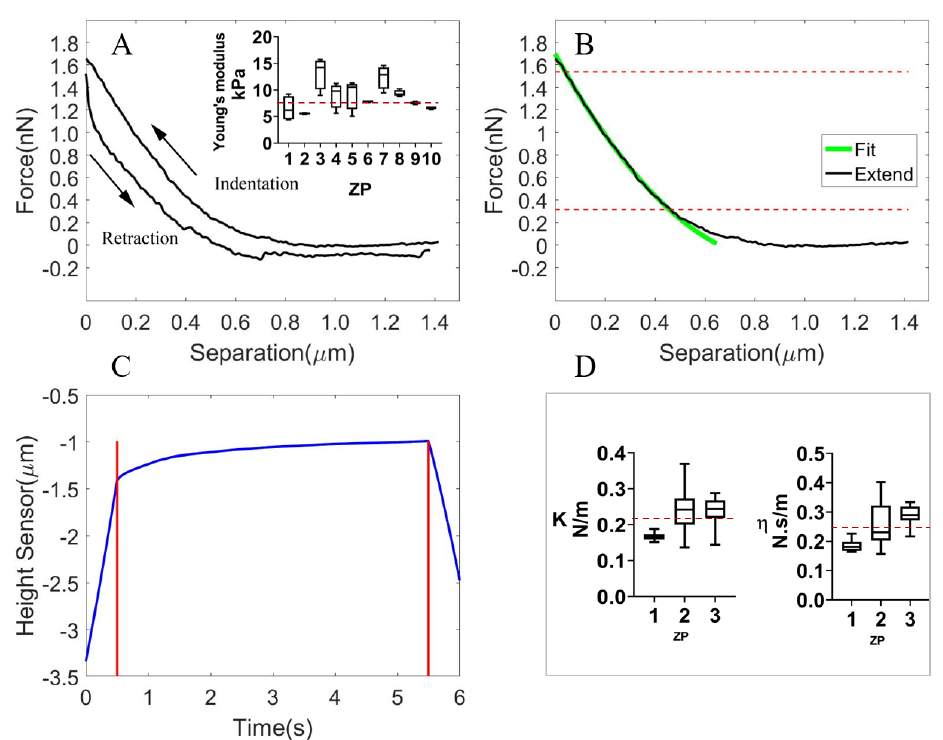
Figure 4. The response of the isolated ZP during AFM indentation for the development of the isolated ZP and cytoplasm model. ( A ) The force-indentation curve (indentation and retraction processes). The included figure shows the estimated Young’s Modulus of multiple ZP lumps. The average value is indicated with the red dotted line. ( B ) The fitting of the indentation (extending process) curve using the Sneddon model (focusing on the portion with a large slope between the two red horizontal lines). ( C ) The viscoelastic creep curve obtained by holding the indenting force at nearly 50 nN for 5 s. ( D ) The k and η values of the Kelvin–Voigt model that were used to describe the viscoelastic creep behavior of the isolated